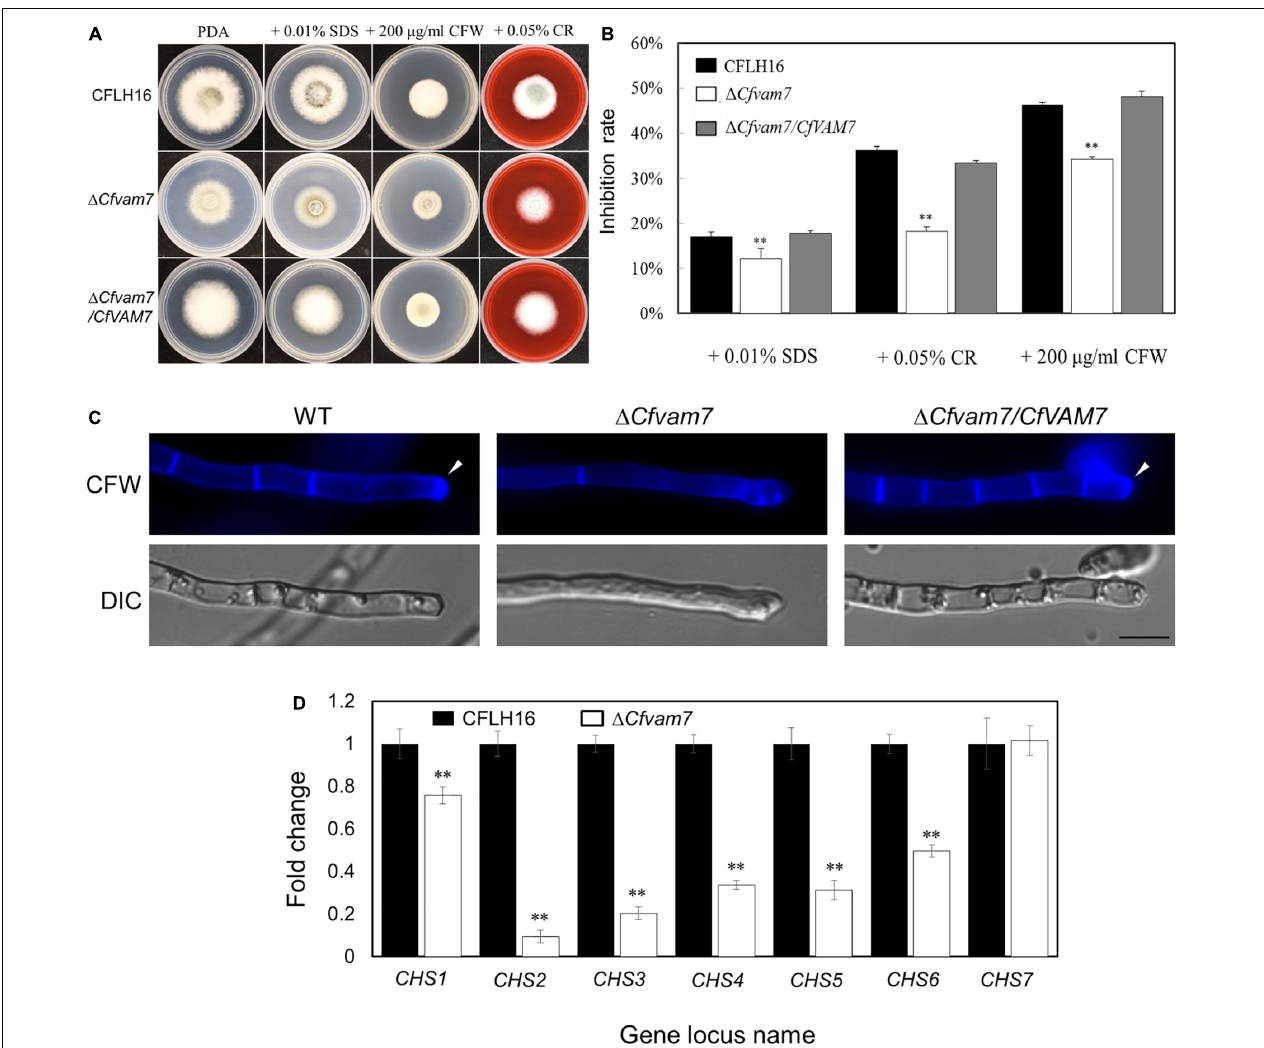
FIGURE 4 | CfVam7 plays roles in cell wall integrity. (A) The wild type (WT), (cid:49) Cfvam7 , and (cid:49) Cfvam7 / CfVAM7 were incubated on potato dextrose agar (PDA) plates with various cell wall stresses of calcofluor white (CFW), Congo red (CR), and sodium dodecyl sulfate (SDS) at 28 ◦ C. (B) Statistical analysis of inhibition rates of the strains to cell wall stresses, and asterisks indicate significant differences ( p < 0.01). (C) The mycelia of the strains were stained with 10 mg/ml of CFW for 5 min without light before being photographed; arrows indicate the stained hyphal tips. The experiment was repeated three times with triplicates, which showed the same results. DIC, differential interference contrast image. (D) Reduced expression was found in six out of seven genes that encode chitin synthases in the (cid:49) Cfvam7 mutants of Colletotrichum fructicola . RNA was extracted from mycelia that were grown for 3 days in liquid potato dextrose broth (PDB). Error bars represent the standard deviation, and “**” represent significant difference among stains tested. All of the reductions are significant ( p = 0.01 or p = 0.05) according to Duncan’s multiple-range